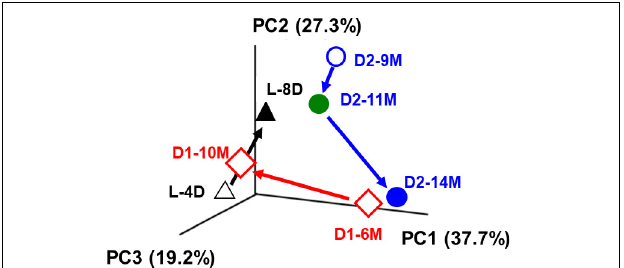
FIGURE 6 | PCoA plot for the bacterial community of the indigo fermentation fluid. Analyzed samples are the initial (L-4D and L-8D) and aged fermentation phases (D1-6M, D1-10M, D2-9M, D2-11M, and D2-14M). L-4D, 4th-day sample, prepared in the laboratory; L-8D, 8th-day sample, prepared in the laboratory; D1-6M, 1st-batch sample, obtained from Date City (42 ◦ 42 (cid:48) N, 140 ◦ 42 (cid:48) E), aged 6 months; D1-10M, 1st-batch sample, obtained from Date City, aged 10 months; D2-9M, 2nd-batch sample, obtained from Date City, aged 9 months; D2-11M, 2nd-batch sample, obtained from Date City, aged 11 months; D2-14M: 2nd-batch sample, obtained from Date City, aged 14 months. This figure was cited from a figure in Okamoto et al. (2017). This reproduction was permitted by Springer-Nature.